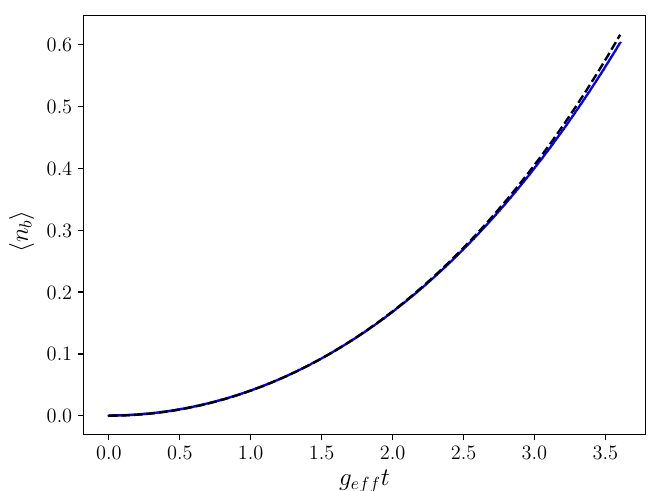
Figure 1. Time averaged transition probability frequency ν generated by the time-dependent Hamiltonian (40); ν g = 0.1, and (cid:101) = 0.9.